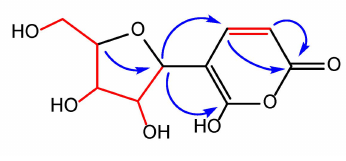
Figure 3. 1 H- 1 H COSY ( ) and selected key HMBC ( ) correlations for Ochraceopyronide.